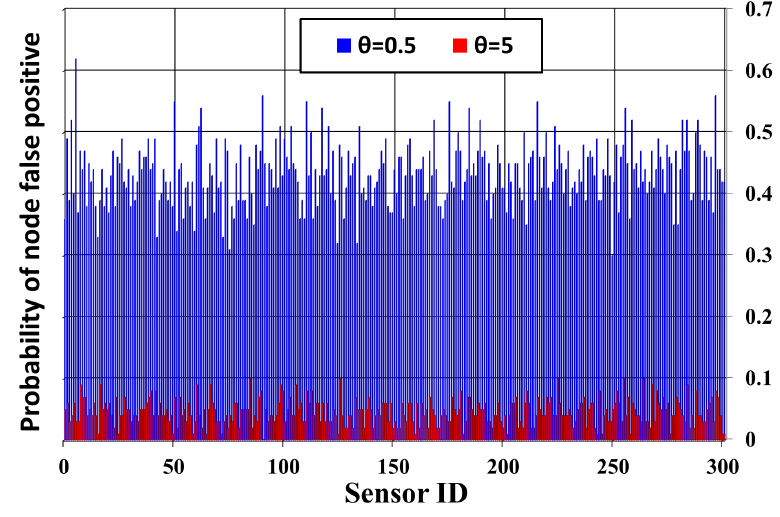
Figure 13. The probability of node false positive of 300 sensors under different detection threshold θ